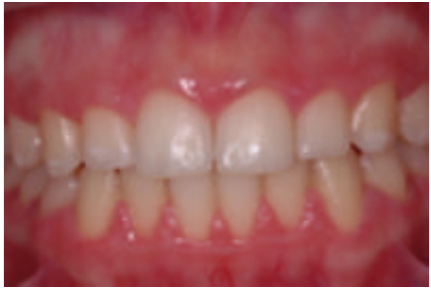
Figure 1: Aspect of Type I.